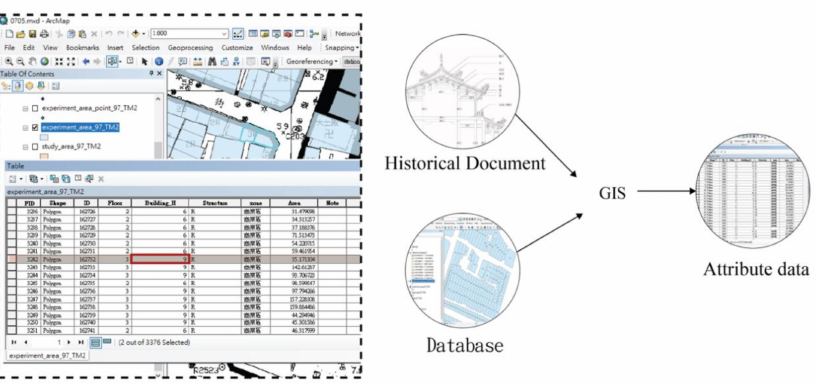
Figure 5. GIS workflow concept map.